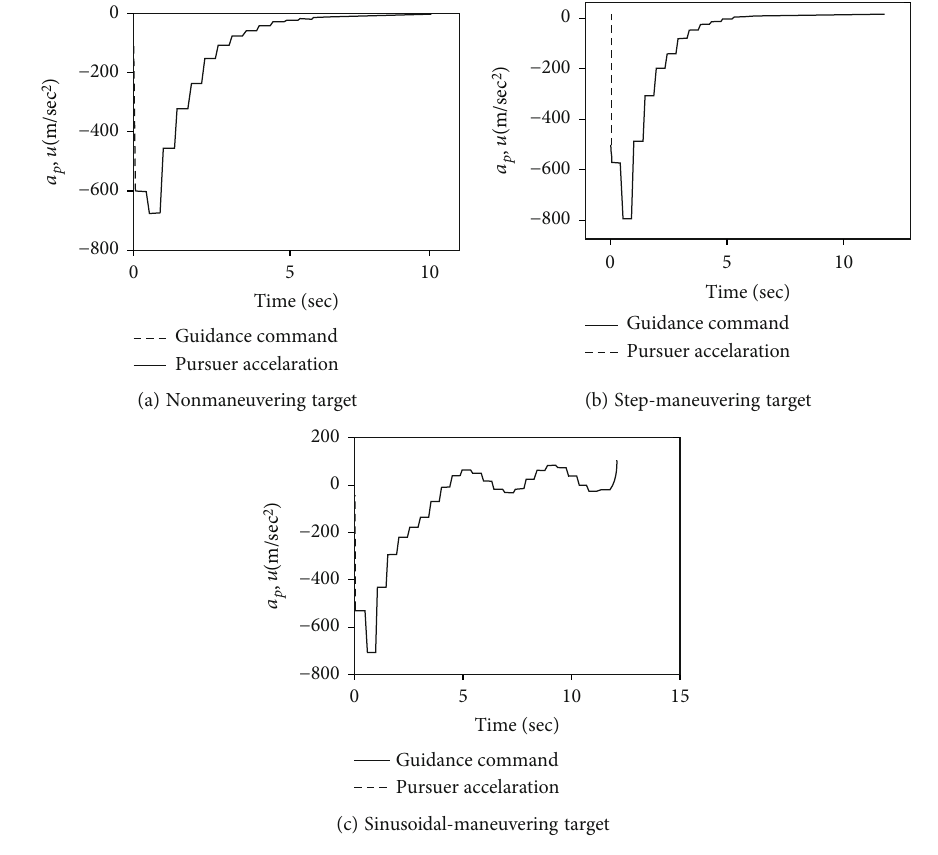
Figure 6: Acceleration of interceptor. Table 1: Interceptor overload requirements of methods studied in other references.